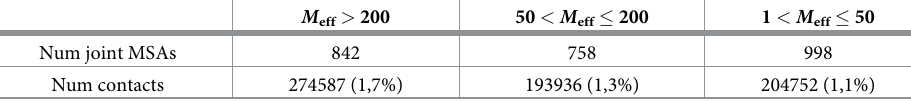
Table 1. We split the 2598 MSAs of interacting domains in 3 datasets according to the effective number of inde- pendent sequences, M eff . They contain approximately the same number of MSAs (first row) and inter-domain con- tacts (second row). In brackets, the percentage of inter-domain contacts is given with respect to the total number of inter-domain residue pairs.